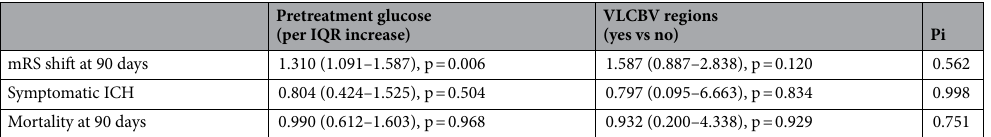
Table 3. Association of pretreatment glucose levels and VLCBV with clinical endpoints. Odds ratios, 95% confidence intervals and p values per IQR increase in pretreatment glucose levels (second column) and according to the presence of very low cerebral blood volume (VLCBV) regions (third column) obtained through unadjusted logistic regression analysis. Pi values (fourth column) are the p values for the interaction between pretreatment glucose levels and the presence of VLCBV regions on each of the evaluated clinical outcomes. ICH intracranial hemorrhage, mRS modified Rankin